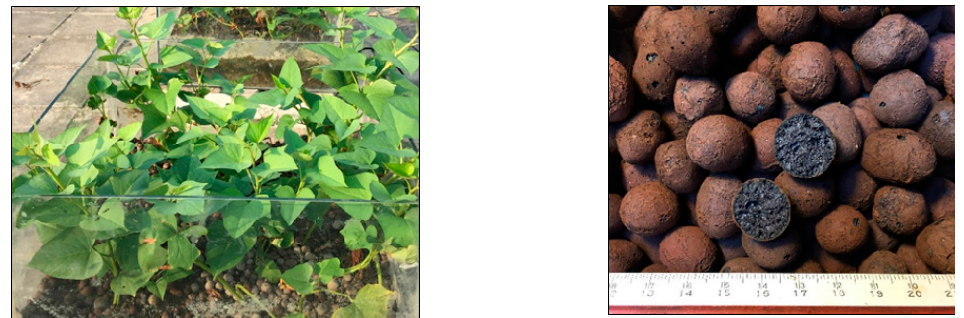
Figure 3. Ipomoea batatas (sweet potato) ( left ) and LECA ( right ). Ruler in centimeters ( right ).